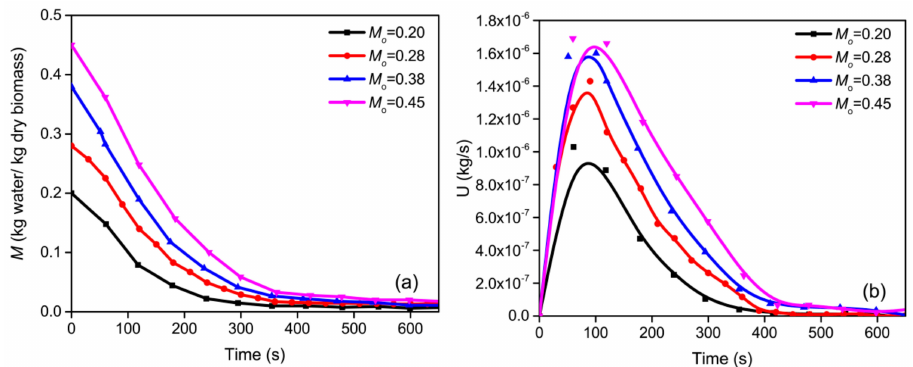
Figure 3. Effects of initial moisture content on biomass drying process: ( a ) drying curves; ( b ) drying rate